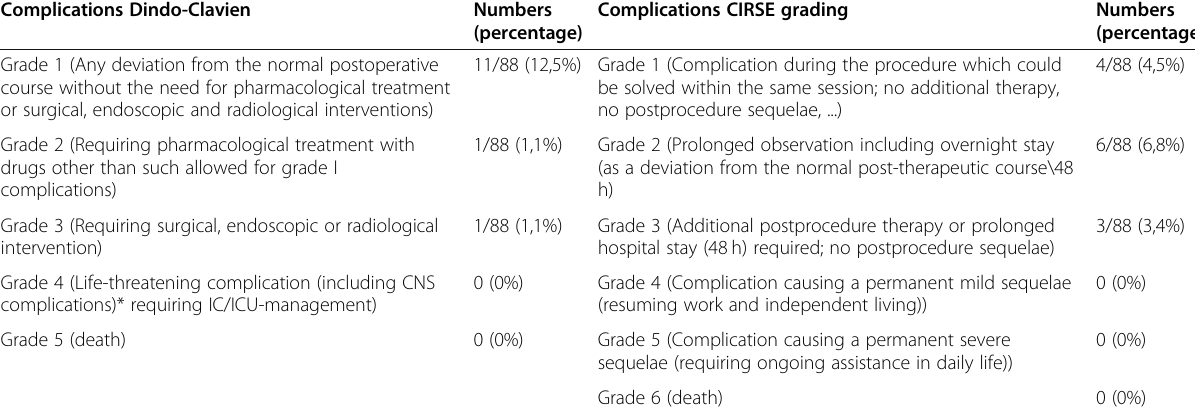
Table 2 Complications of PVE scored by the Clavien Dindo score and the CIRSE score Complications